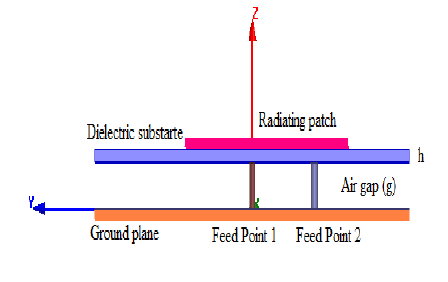
Figure 2. Side view of proposed antenna (Feed Point 1 = (-13, 0) mm, Feed Point 2 = (0, -13)